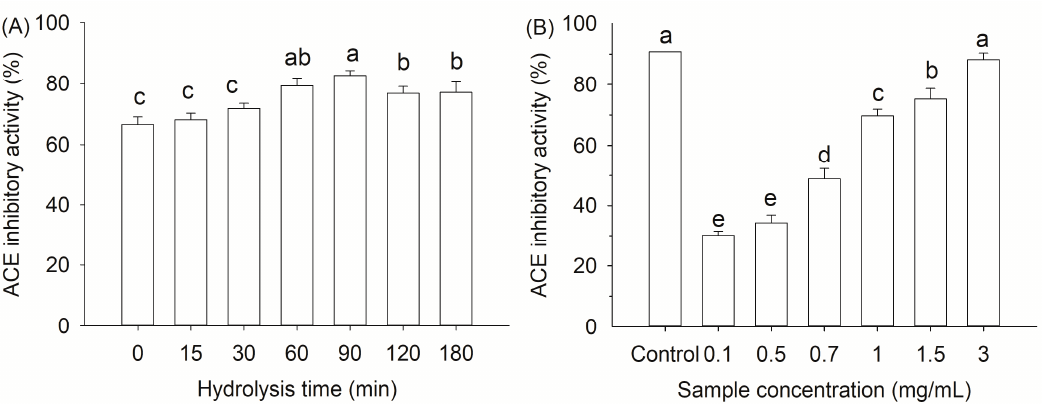
Figure 5. Effect of hydrolysis times ( A ) and sample concentration ( B ) on ACE inhibitory activity of gelatin hydrolysates. Captopril (10 μ M) served as a positive control. Different letters indicate that the results differ signi fi cantly ( p < 0.05).